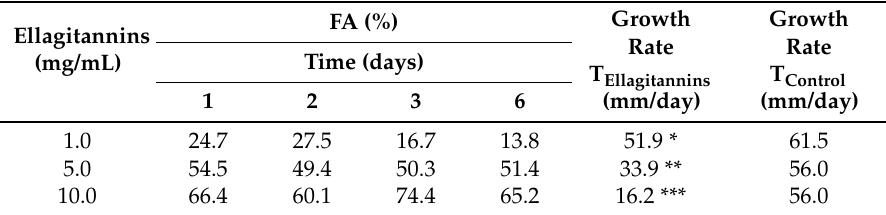
Table 4. Fungistatic activity (FA) of the raspberry ellagitannin preparation (REP) and the linear growth rate (T) for Geotrichum candidum